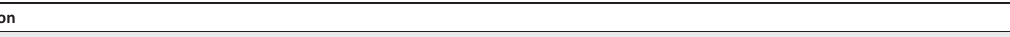
TABLE 1-A4: Description of outcome